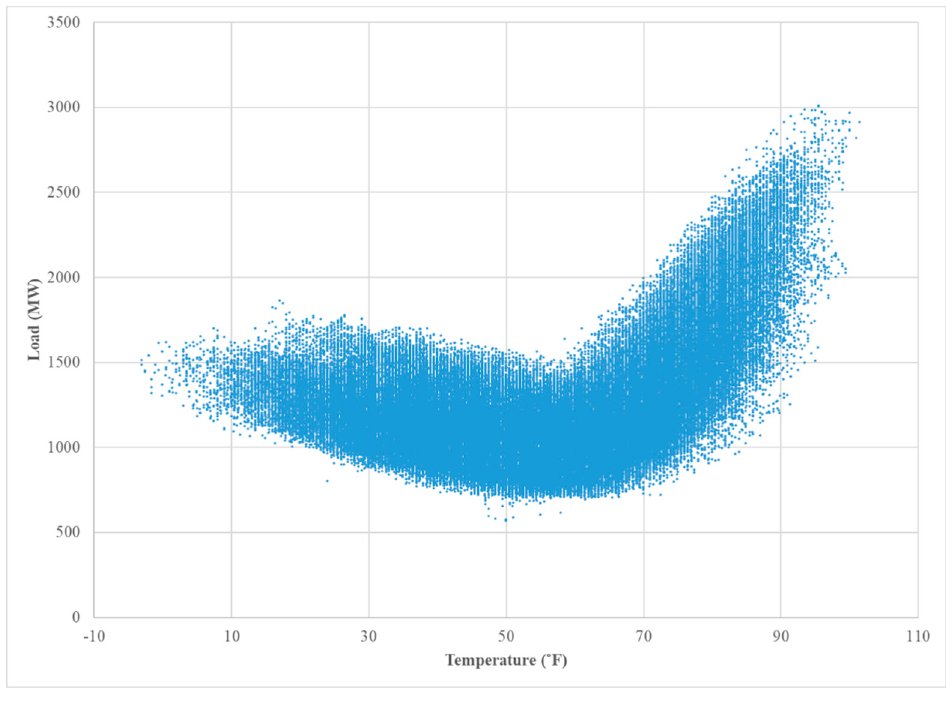
Figure 2. The relationship between the hourly load and hourly temperature—South New Jersey 1993–2012.